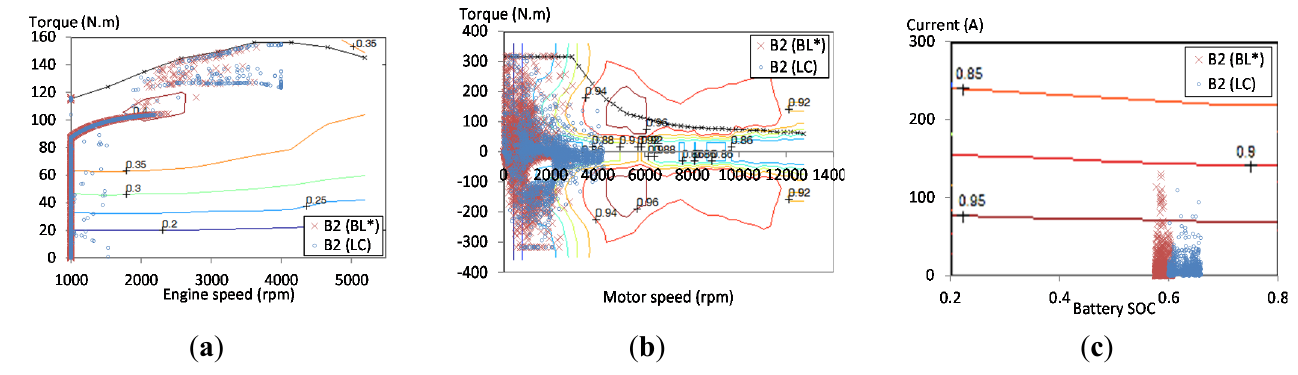
Figure A2. Plots of B2 solution engine ( a ), electric motor ( b ), and battery ( c ) operation for BL and LC driving cycles. (* driving cycle used in the optimization).